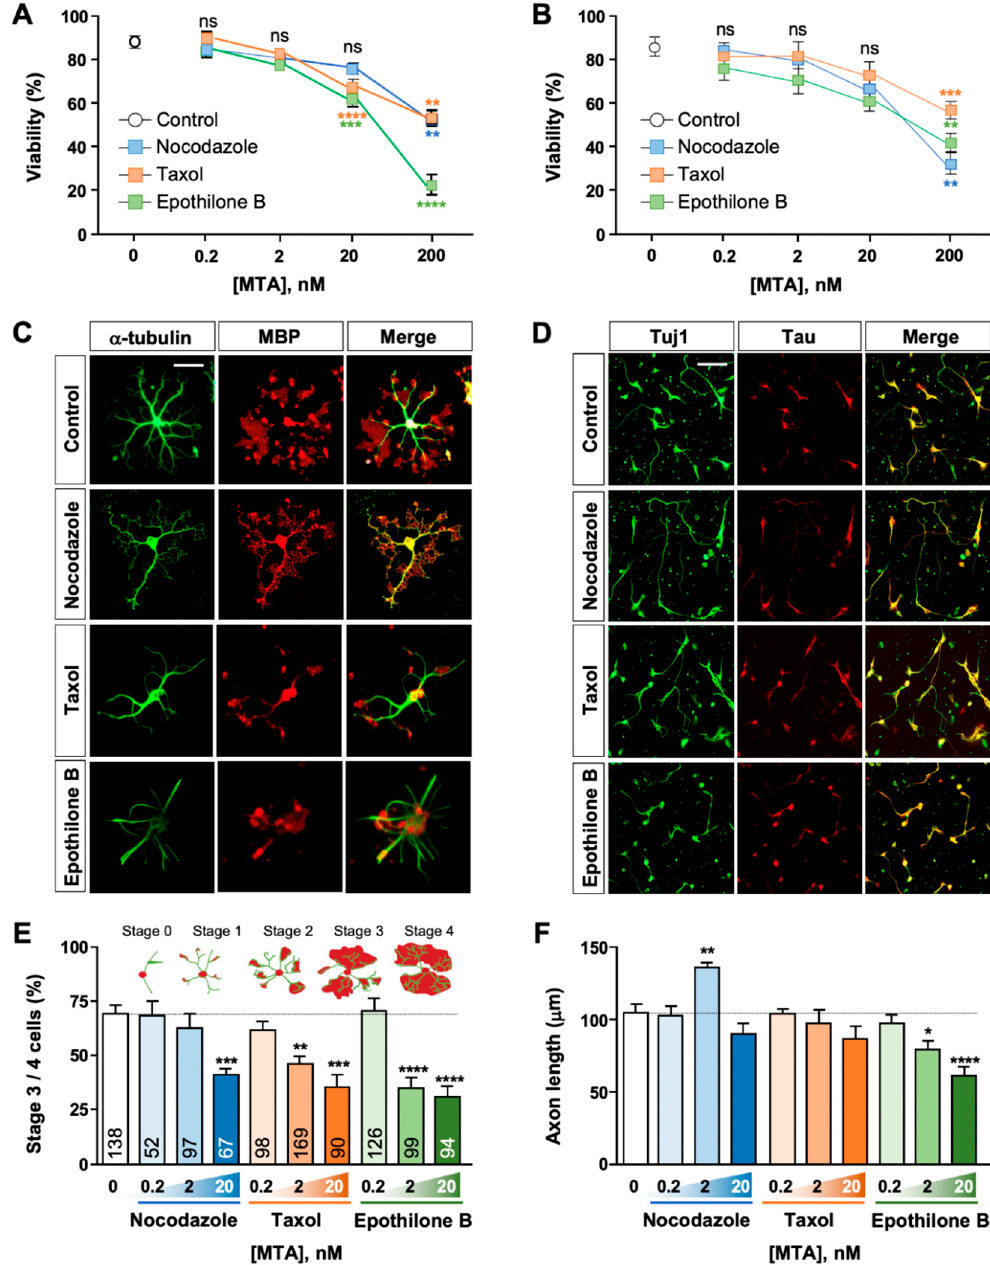
Figure 2. Effects of MTAs in oligodendrocytes and neurons. ( A , B ) Cell viability of oligodendrocytes ( A ) or cortical neurons ( B ) cultured in the absence or presence of varying concentrations of MTAs. In oligodendrocytes, MTAs were treated at DIV 3 until fixation at DIV 10. In neurons, MTAs were treated at 5–6 h after plating until fixation at DIV 3. Cell viability was quantified as described in Materials and Methods. Graph shows mean ± SEM. n = 12 in ( A ), n = 5 in ( B ). ( C , D ) Representative images of oligodendrocytes ( C ) and cortical neurons ( D ) treated with MTAs (2 nM) or vehicle control. Scale bar, 25 µm. ( E ) Percentage of differentiated oligodendrocytes (stages 3 and 4) cultured in the absence or presence of varying concentrations of MTAs. Inset, morphological classification of differentiating oligodendrocytes. Detailed criteria for each stage are described in the text. Graph shows mean ± SEM. Total numbers of cells pooled from at least four independent experiments are depicted in each bar. ( F ) Quantification of axon length from cortical neurons cultured in the absence or presence of varying concentrations of MTAs. Graph shows mean ± SEM. n = 5. * p < 0.05, ** p < 0.01, *** p < 0.001, and **** p < 0.0001; ns, statistically not significant. Student’s t -test in ( A , B , E ), and Mann–Whitney test in ( F ).